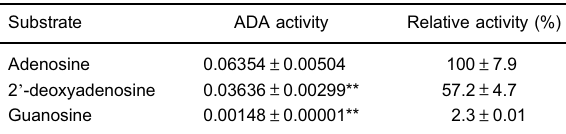
Table 1. Adenosine deaminase (ADA) substrate speci fi city in human lymphocyte-rich peripheral blood mononuclear cells (10 mM; n=4).